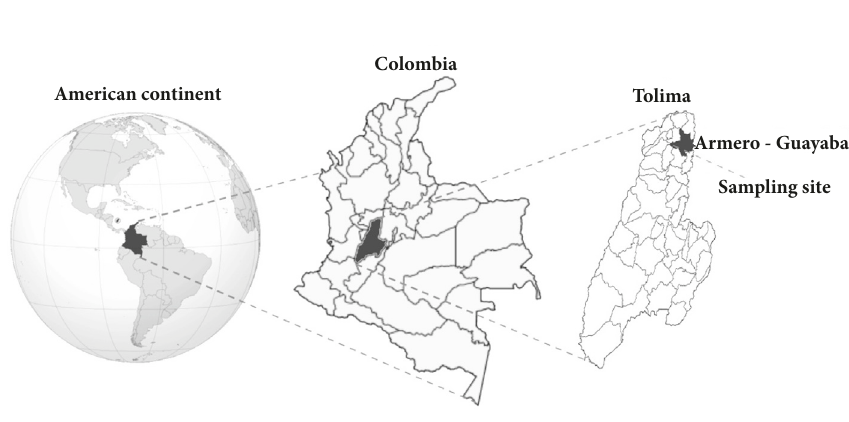
Figure 1: Geographic localization of clay